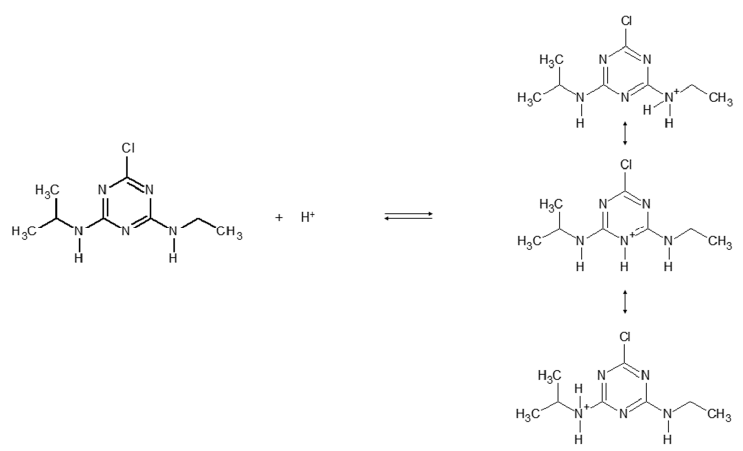
Figure 4. Protonation equilibria of atrazine.